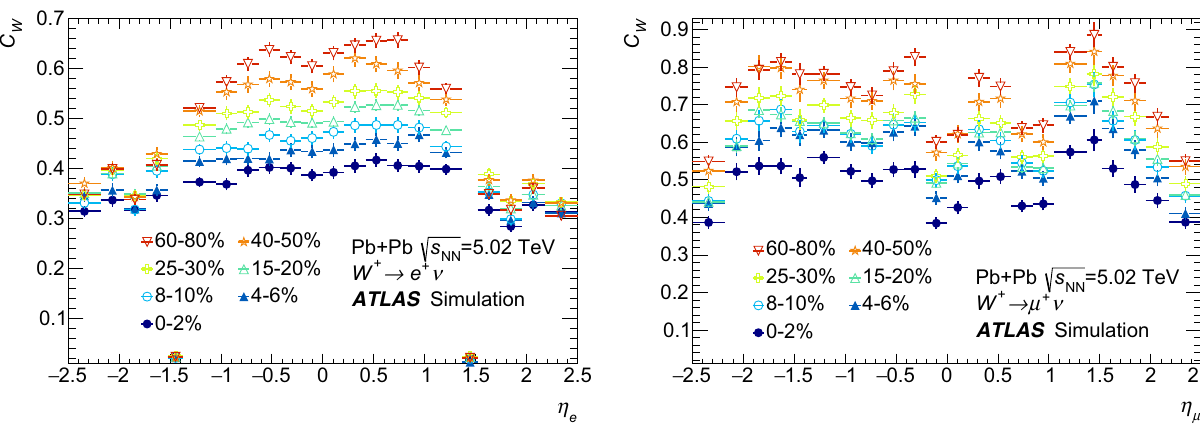
Fig. 4 Correction factor C W for positive electrons (left) and positive muons (right) as a function of η (cid:4) evaluated in selected centrality classes. The error bars represent the statistical uncertainties